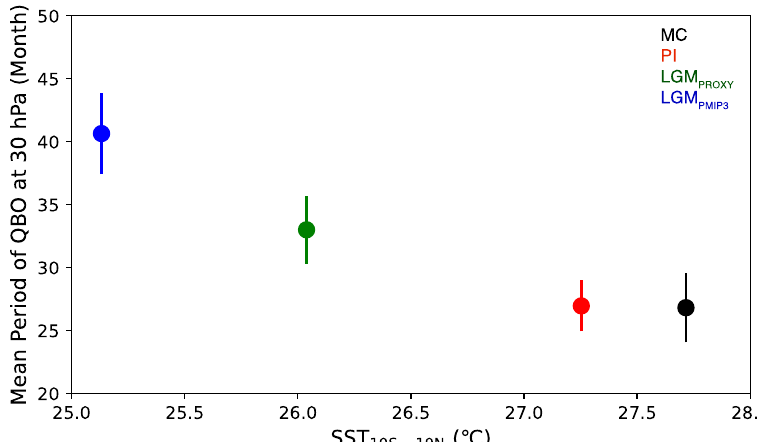
Figure 3. Mean period of the QBO at 30 hPa as a function of the SST averaged over 10° N/S in the simulations of Last Glacial Maximum with the PMIP3-simulated SST (LGM PMIP3 ), Last Glacial Maximum with the proxy SST (LGM PROXY ), and modern (MC) and preindustrial (PI) climate with observed SST and sea ice.